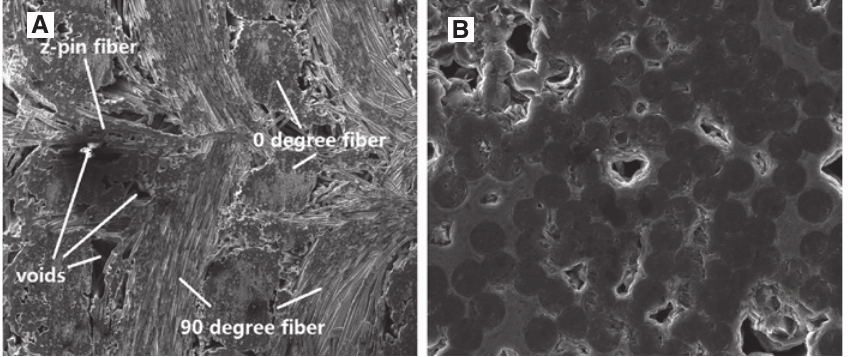
Figure 3: Micrographs of the Cf/SiC composite: (A) distribution of voids and fiber bundles and (B) distribution of fibers and the matrix, and the porosity within the fiber